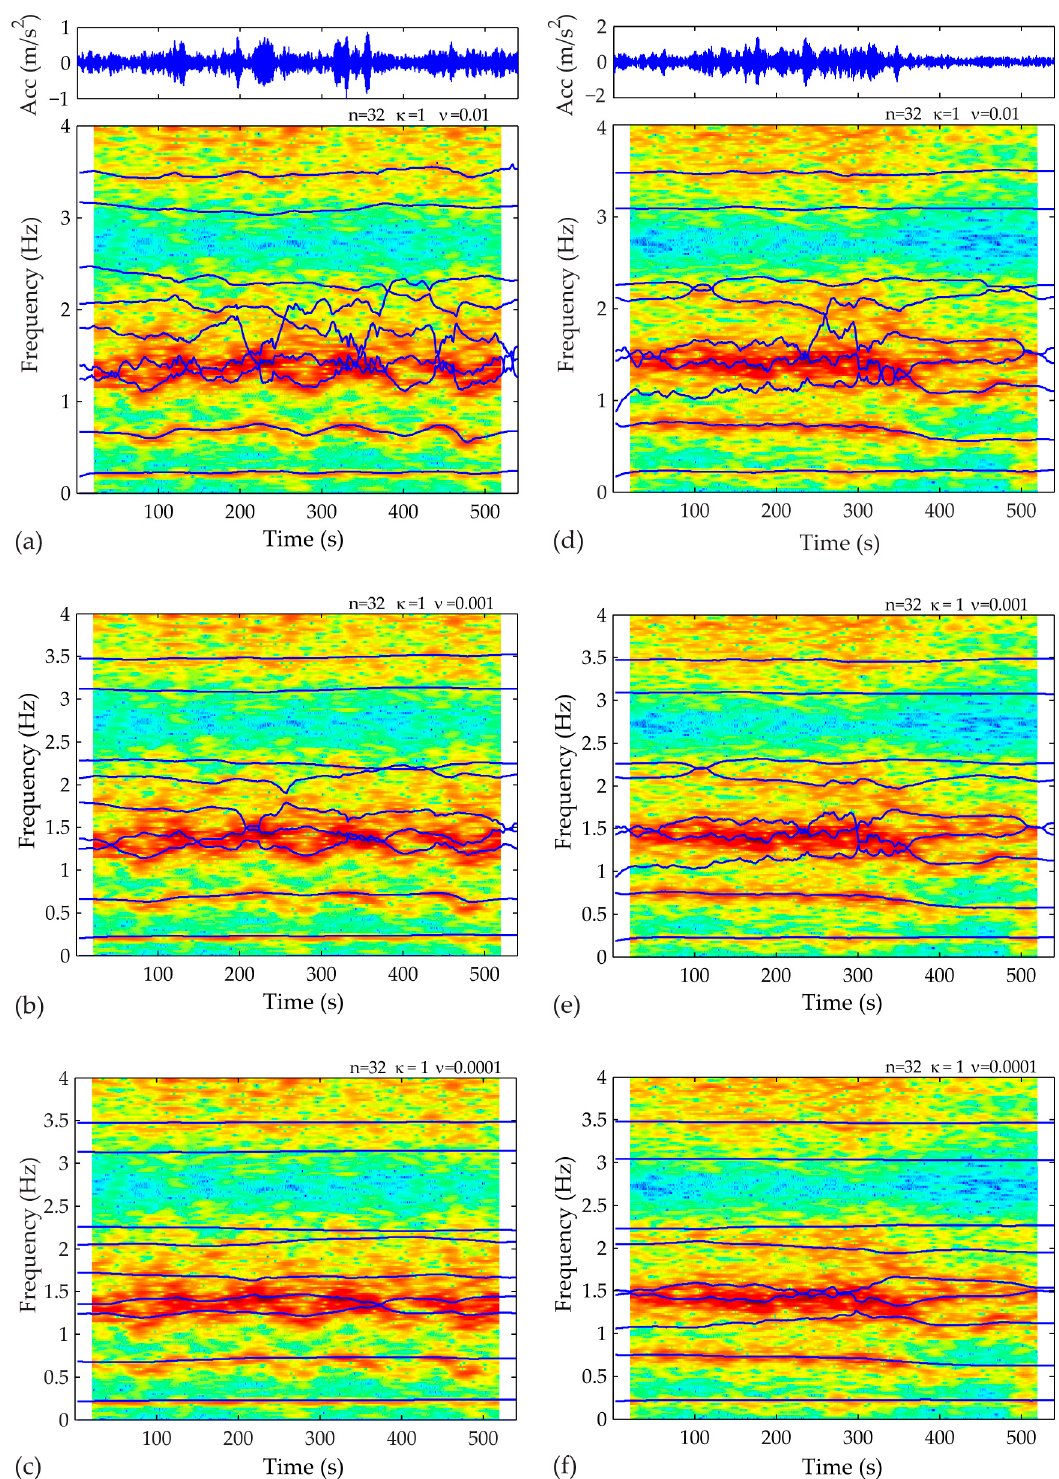
Figure 9. SP-TARMA (n = 32, k = 1) model tuning for Case A by varying the value of the ratio of model residuals. First sample of a 10-min acceleration signal fitted with: ( a ) ν = 0.01; ( b ) ν = 0.001; ( c ) ν = 0.0001; Second sample of a 10-min acceleration signal fitted with: ( d ) ν = 0.01; ( e ) ν = 0.001; ( f ) ν = 0.0001.